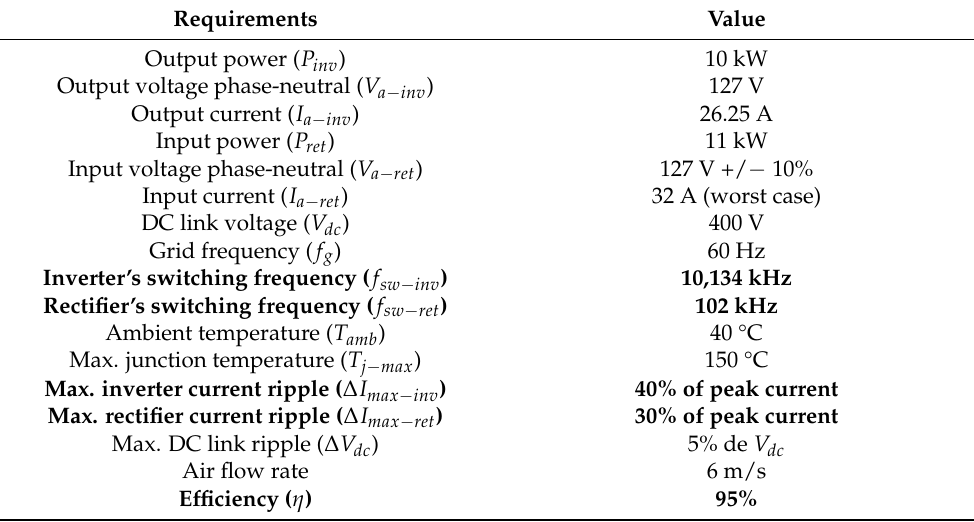
Table 2. Requirements and design criteria for the UPS from